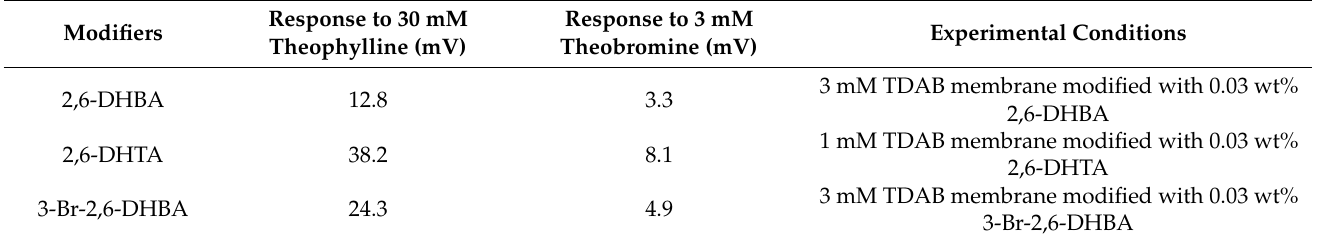
Table 5. Response to 30 mM theophylline and 3 mM theobromine obtained from 2,6-DHBA, 2,6-DHTA and